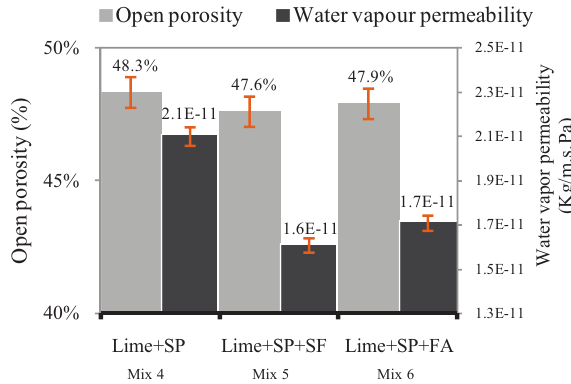
Fig. 9(b). Effect of pozzolans and SP on water vapour permeability of grout